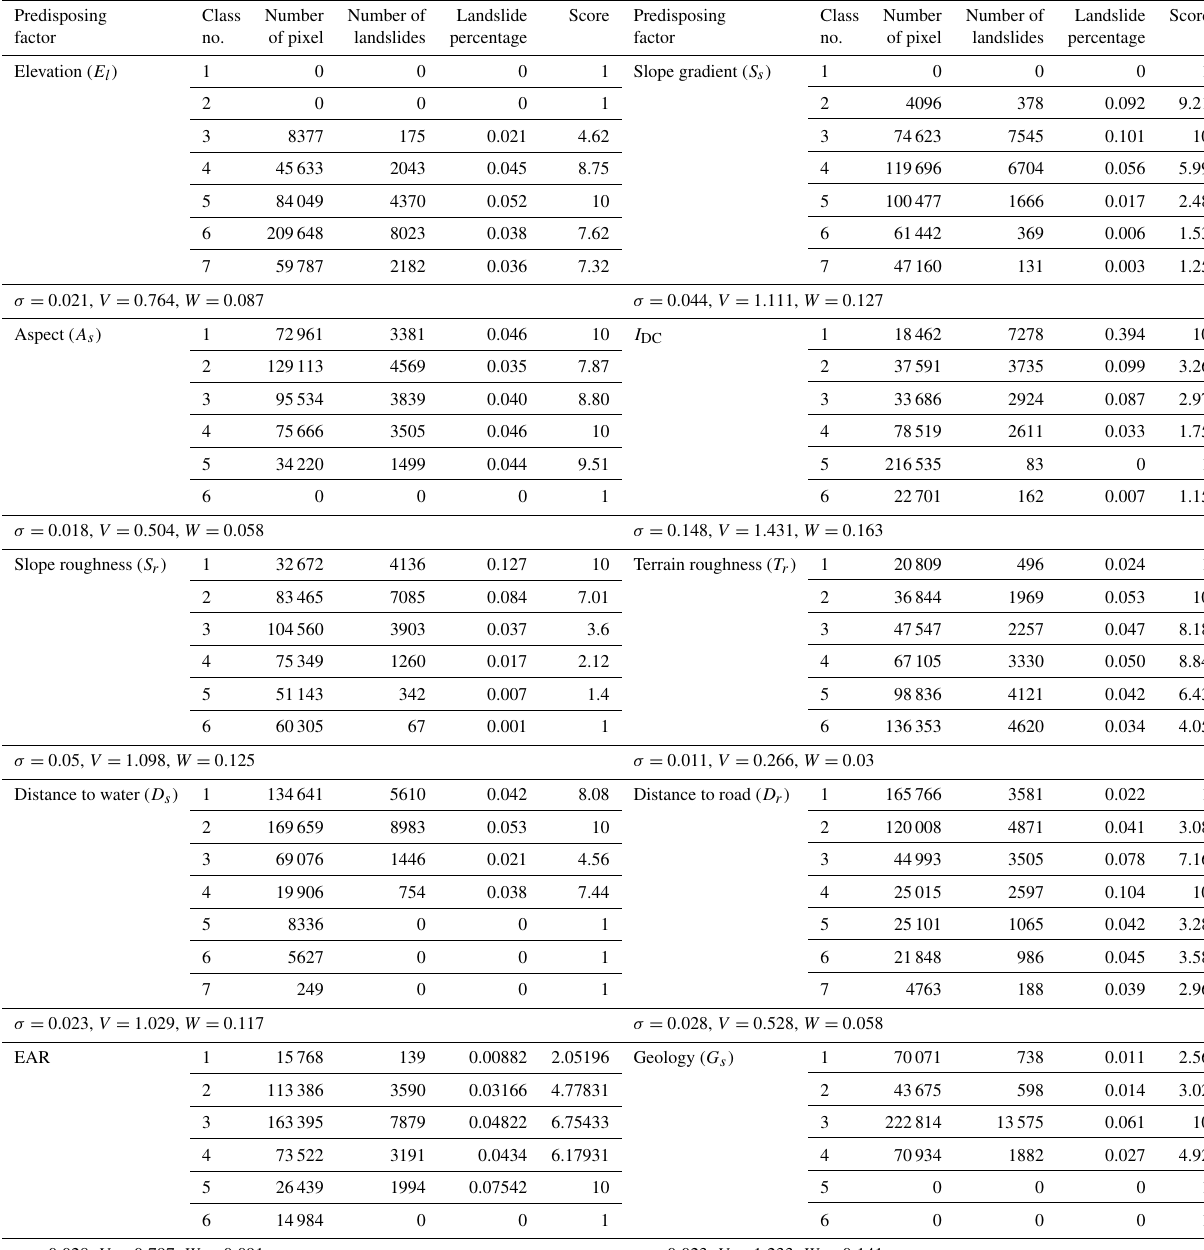
Table A1. Weights and scores of predisposing factors after rainfall brought by Typhoon Nanmadol in